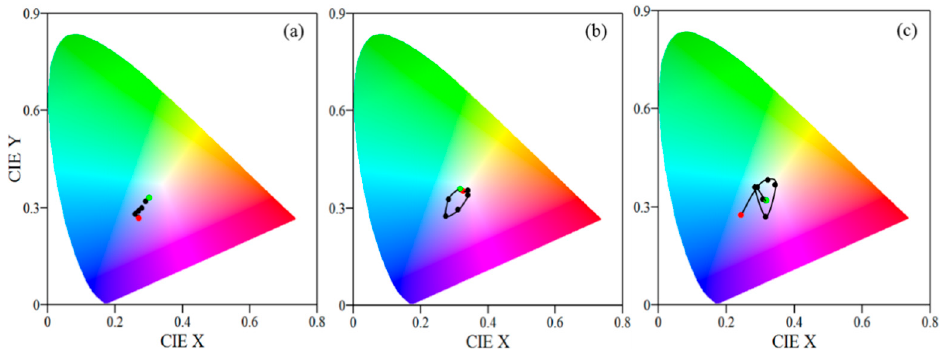
Figure 4. CIE color coordinates for polymer films with initial thickness of 100 nm ( a ), 200 nm ( b ), and 300 nm ( c ) deposited on silicon substrate and exposed to different humidity levels starting from 5% RH (red circle) and ending at 90% RH (green circle). The middle values are 30%, 40%, 50%, 60%, 70%, and 80% RH.